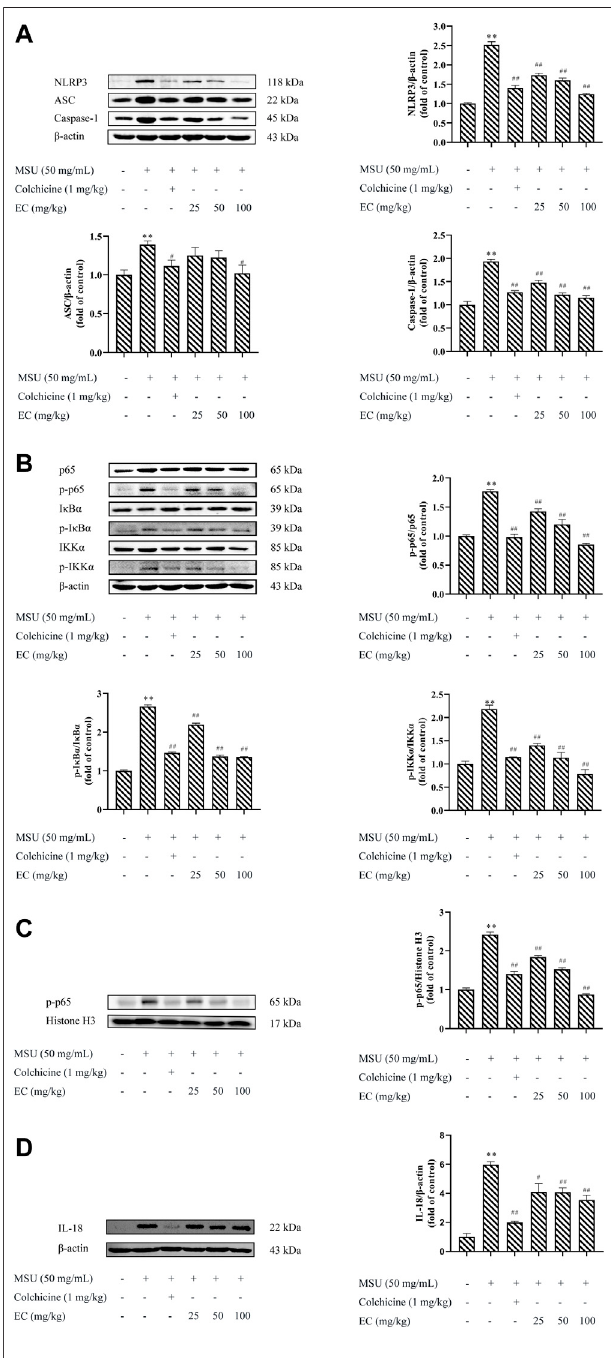
FIGURE7| InhibitoryeffectsofEC ontheprotein expressions ofNLRP3 in fl ammasome and the NF- κ B pathway in the MSU-induced mice ankle joint. Mice were intragastrically administrated with different doses of EC consecutively for 7 days, followed by MSU (0.025 ml MSU suspension with 50 mg/ml) injection into the ankle 1 h after EC administration on the sixth day. The ankle joint 24 h after MSU injection was collected and then detected by western blotting. (A) The protein expressions of NLRP3 in fl ammasome components. (B) RelatedproteinexpressionsoftheNF- κ Bsignalingpathway. (C) Expression of NF- κ B translocation. (D) IL-18 expression in ankle joint tissues. Data are represented as mean ± SEM of three independent